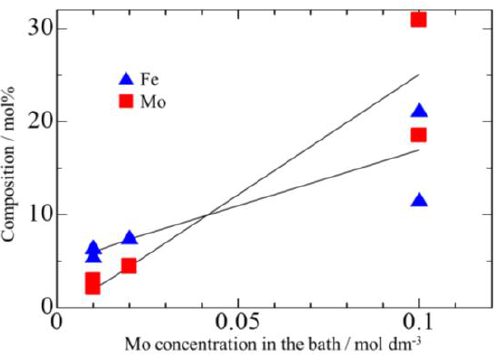
Figure 13. Content of Fe and Mo in the Zn–Fe–Mo plating deposited from a plating bath with different Mo concentrations.